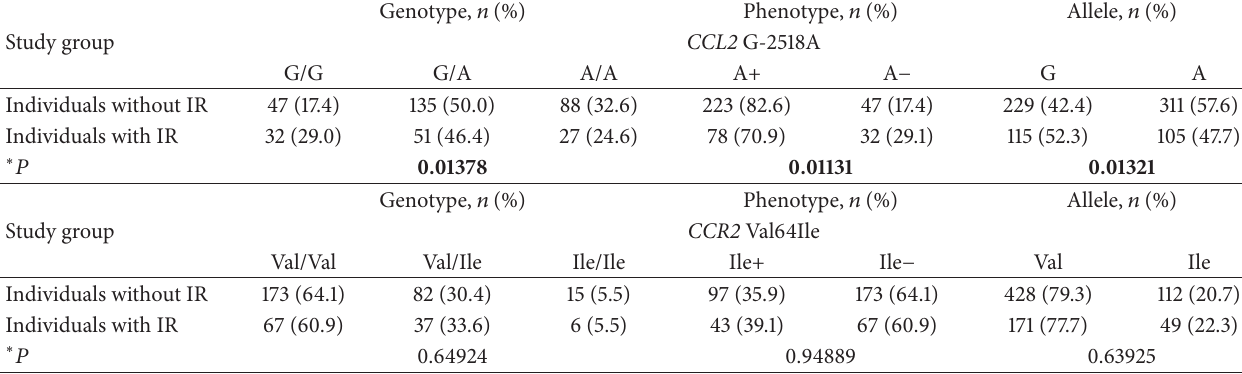
Table 3: Distribution of CCL2 (G-2518A) and CCR2 (Val64Ile) gene polymorphism in Mexican-Mestizo population.